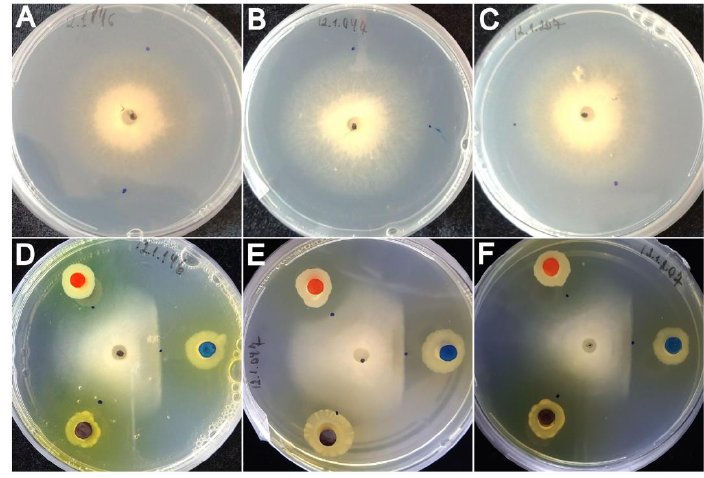
Figure 2. In vitro antagonism by strains of fluorescent Pseudomonas species against Pyricularia oryzae Triticum lineage ( PoTl ). ( A – C ): PoTl isolates only (12.1.146, 12.1.047 and 12.1.207). ( D – F ): P. wayambapalatensis ‘ Amana ’ (blue mark; P. putida group); Pseudomonas sp. nov. ‘ Poti ’ (black mark; P. asplenii group) and Pseudomonas sp. nov. ‘ Yara ’ (red mark; P. putida group) paired with PoTl (colony in the center).